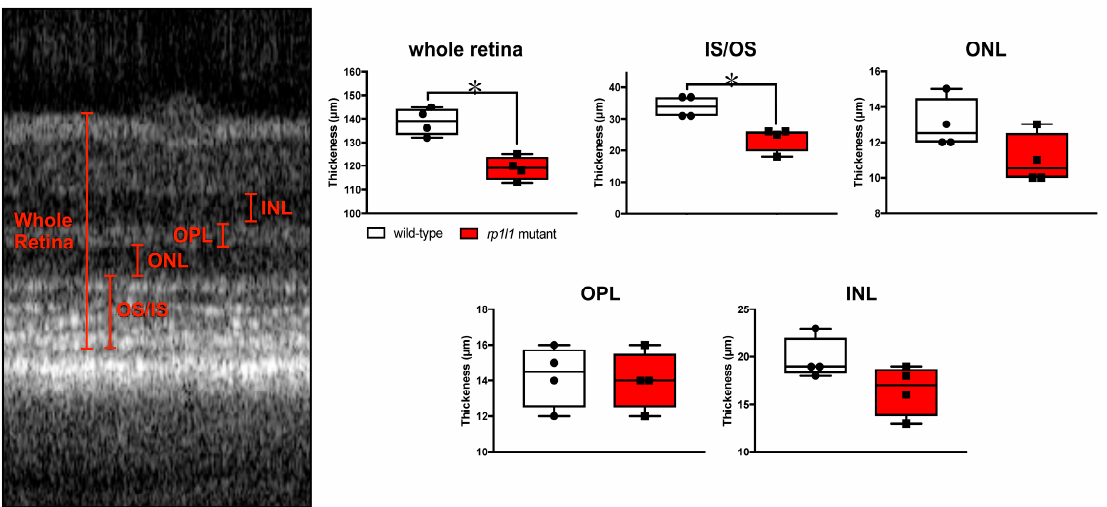
Figure 6. rp1l1 mutant zebrafish have thin retinas. Measurements of retinal thickness from OCT scans